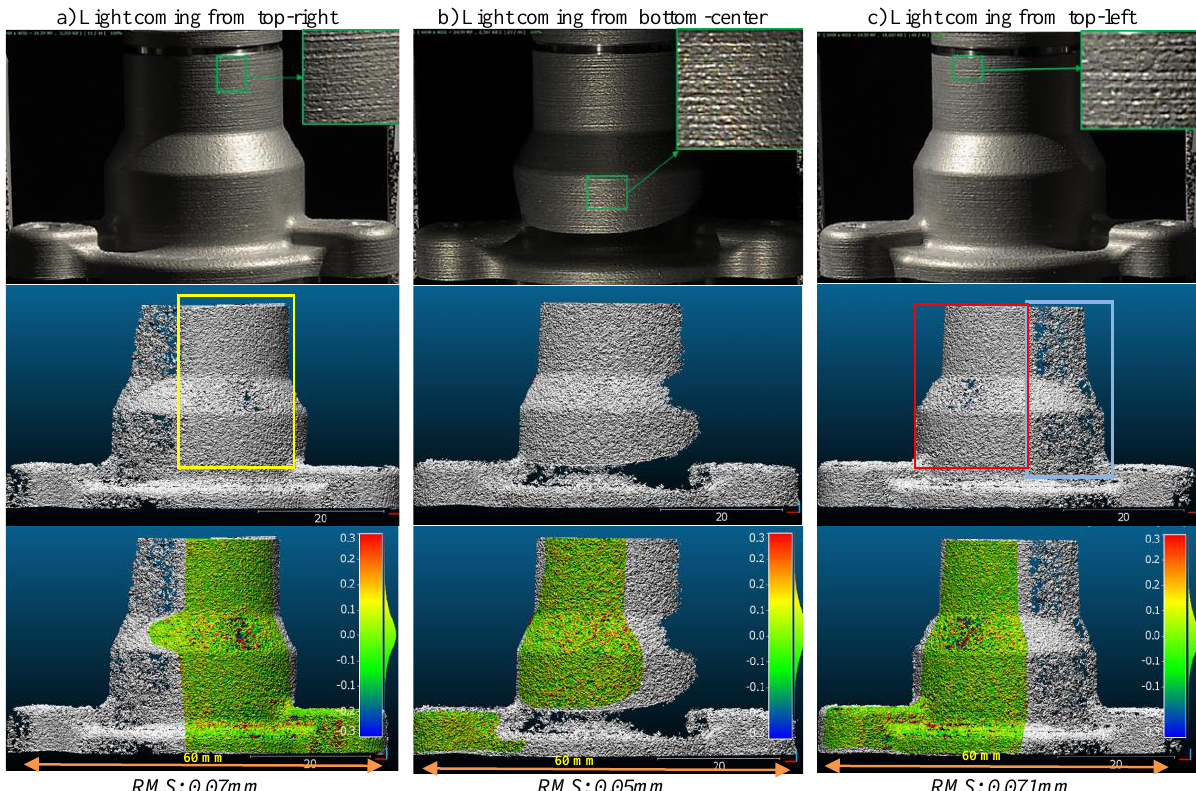
Figure 7. The importance of grazing angle to improve dense image matching by highlighting microstructures on the surface. Samples of images taken under different grazing angles and a closer view that shows the highlighted roughness (first row). Individual 3D reconstructions generated under different grazing angles using only a stereo pair (second row). Result of point-to-point comparison on selected areas between the reference data and the proposed 3D reconstruction method (third